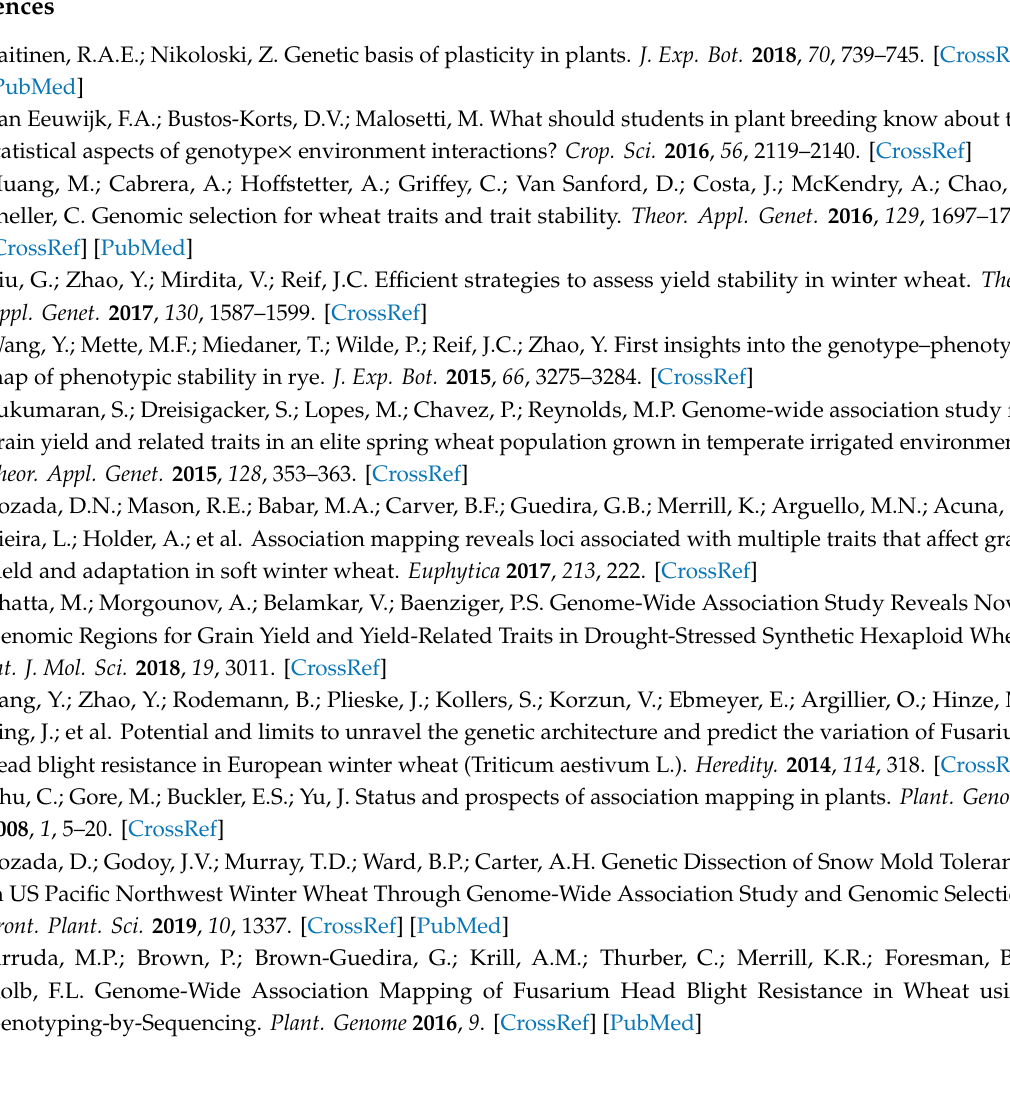
Table S1. Variance, sum of squares, and mean square for the interaction principal components for an AMMI analysis for grain yield, heading date, and plant height in US Pacific Northwest winter wheat.; Table S2. AMMI stability values (ASV) and ASV rank for the US Pacific Northwest winter wheat lines; Table S3. Phenotypic stability indices for grain yield, heading date, and plant height for the US Pacific Northwest winter wheat lines; Table S4. SNP markers associated with trait and trait stability in US Pacific Northwest winter